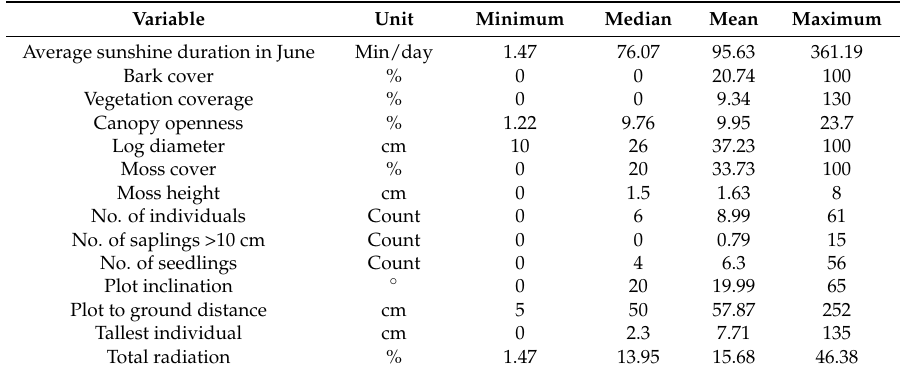
Table 1. Minimum, median, mean, and maximum values of the variables assessed on each plot (not including factorial variables).